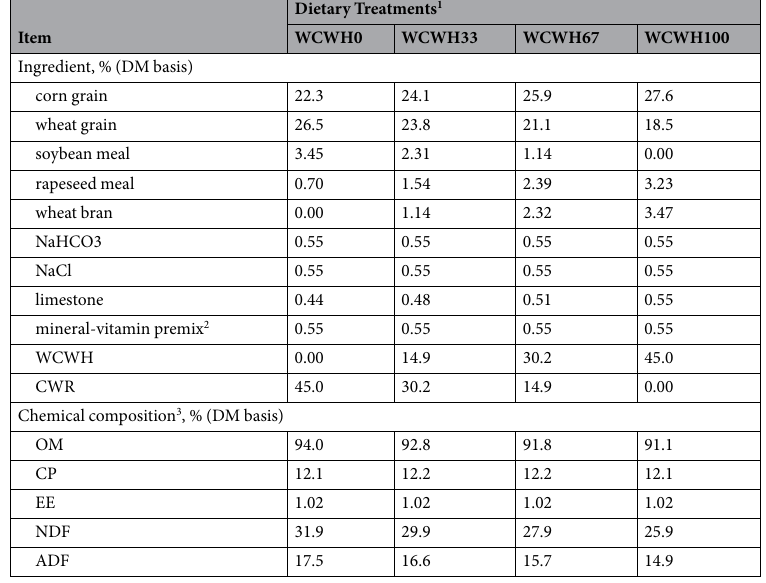
Table 4. Ingredients and nutrient compositions of the dietary treatments. 1 WCWH0 = 0% of Leymus chinensis was replaced by whole-crop wheat hay; WCWH33 = 33% of Leymus chinensis was replaced by whole-crop wheat hay; WCWH67 = 67% of Leymus chinensis was replaced by whole-crop wheat hay; WCWH100 = 100% of Leymus chinensis was replaced by whole-crop wheat hay. 2 Every kilogram of mineral–vitamin premix contained the following: 3500 IU Vitamin A, 3000 IU Vitamin D 3 , 45 IU Vitamin E, 63 mg Zn, 60 mg Fe, 98.6 mg Mn, 20 mg Cu, 1.1 mg I, 0.50 mg Se, and 0.45 mg Co. 3 OM = organic matter; CP = crude protein; NDF = neutral detergent fibre; ADF = acid detergent